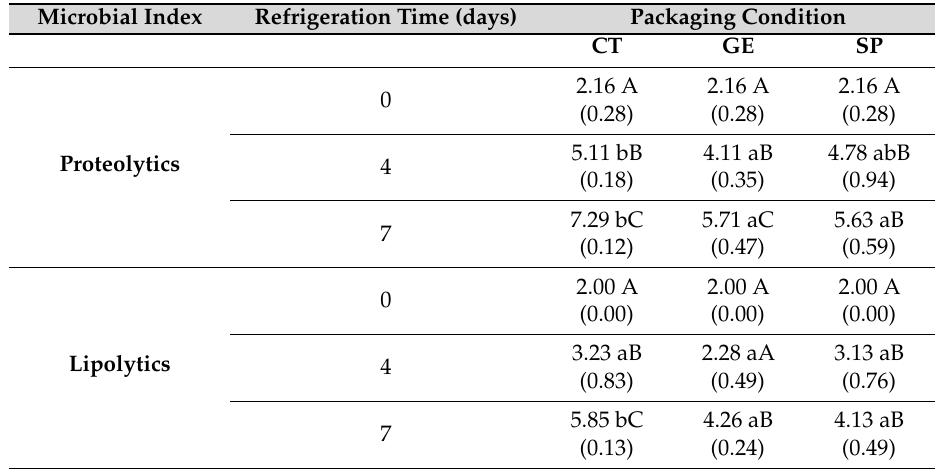
Table 2. Proteolytics and lipolytics count assessment (log CFU · g − 1 muscle) * in mackerel muscle stored under di ff erent packaging conditions